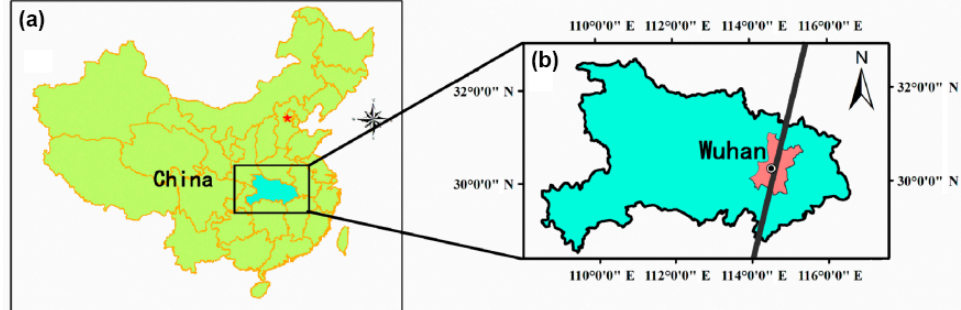
Figure 1. Geographic location of the ground-based lidar measurement station. The black point represents the ground-based lidar station. The black line represents the track of CALIPSO